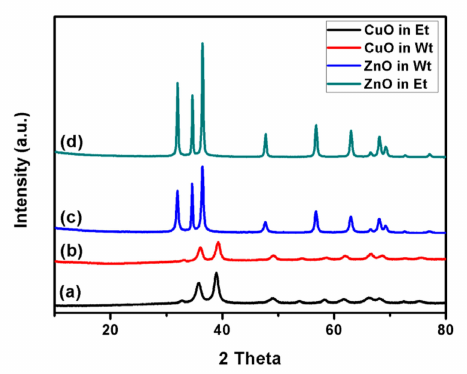
Figure 3. XRD spectra of CuO NPs synthesized in ethanol ( a ) or in water ( b ). ZnO NPs synthesized in water ( c ) or in ethanol ( d